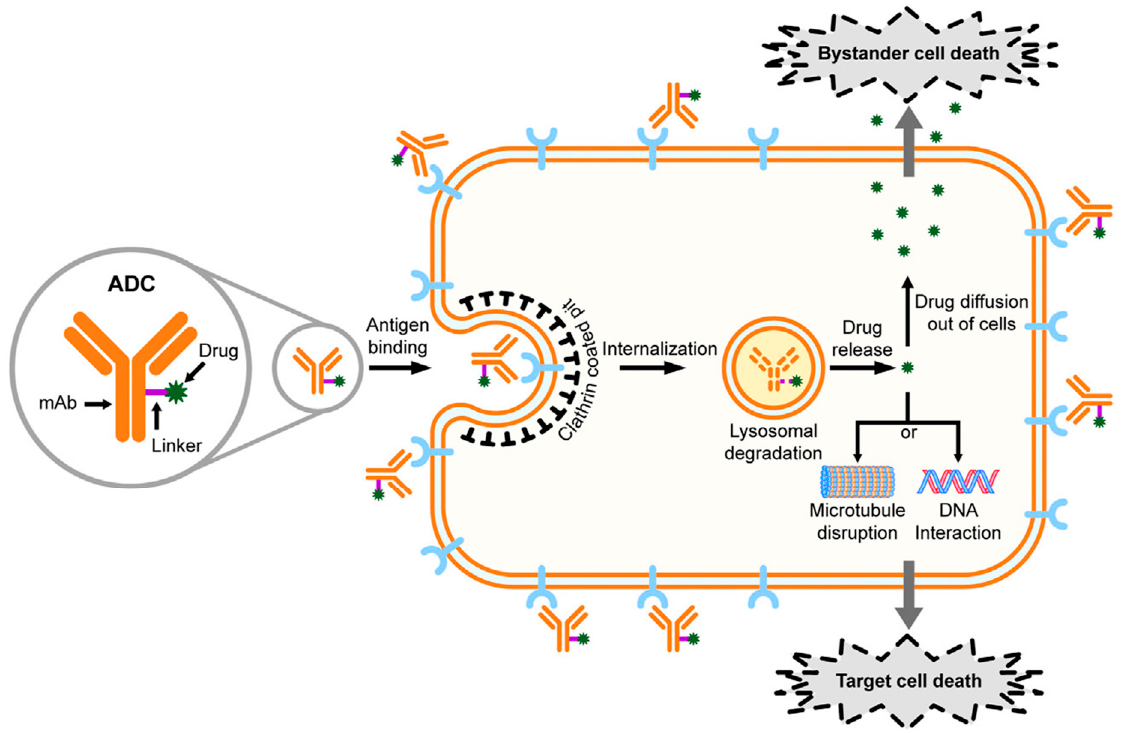
Figure 1. Mechanism of action of ADC drugs. Adapted from [2].